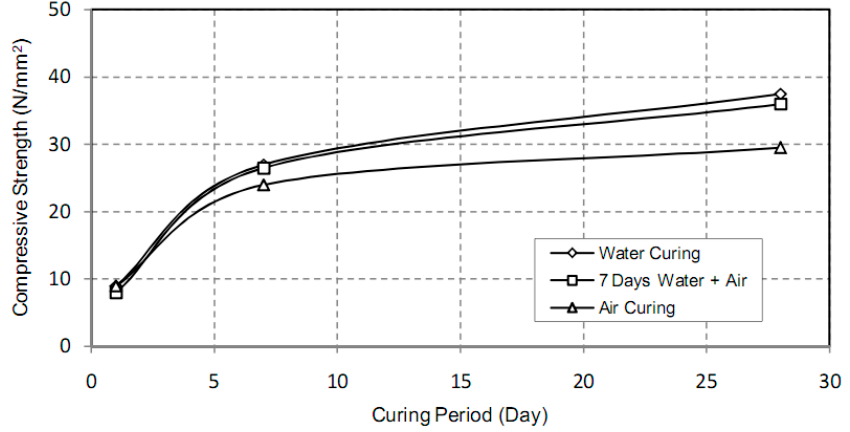
Figure 11. Influence of curing on the POFA concrete strength [57]. Reprinted with permission from Awal et al. [57].